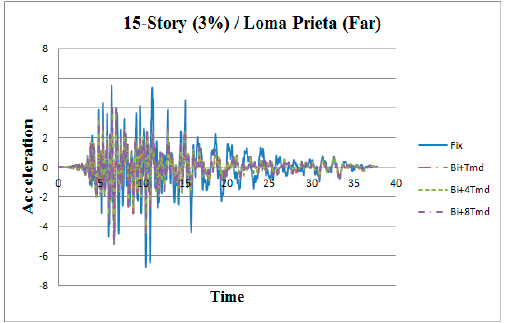
Figure A1. Acceleration time histories for top story of 15-story building under the Imperial Valley (far-fault) earthquake.